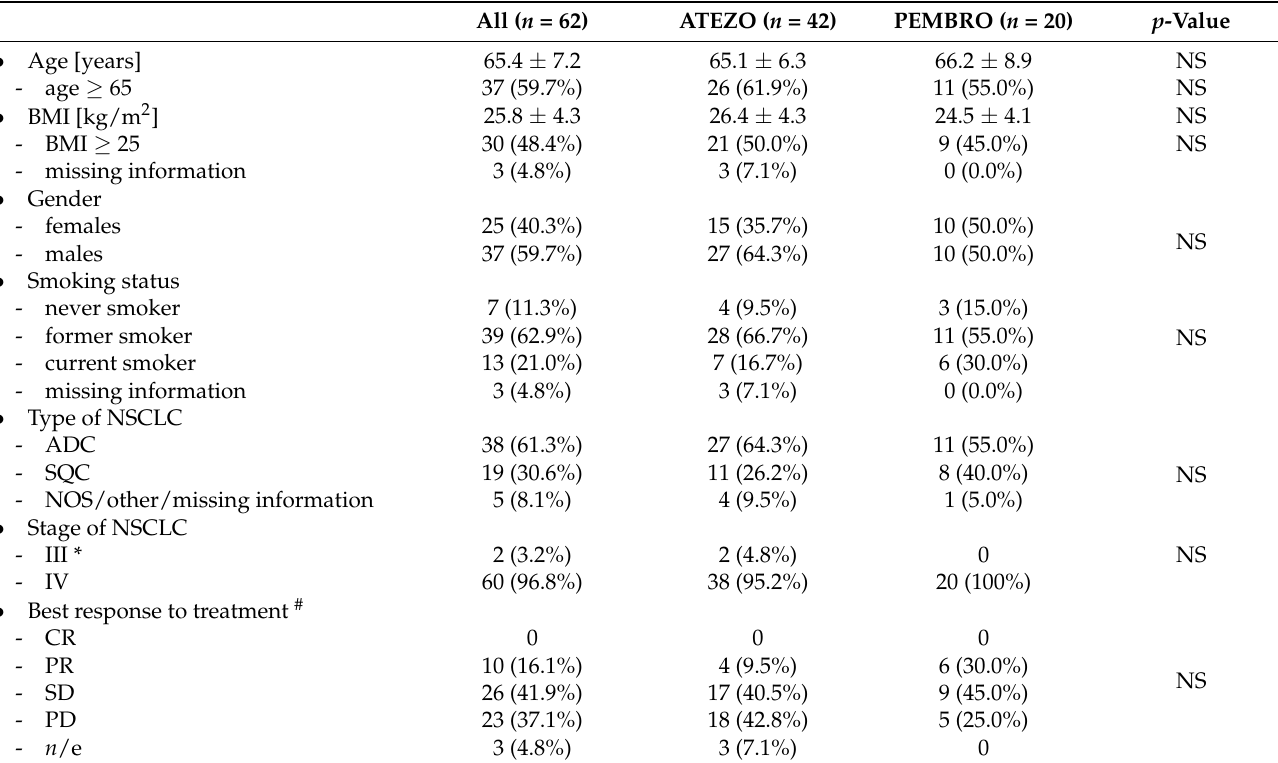
Table 1. Characteristics of NSCLC patients treated with anti-PD-1/PD-L1